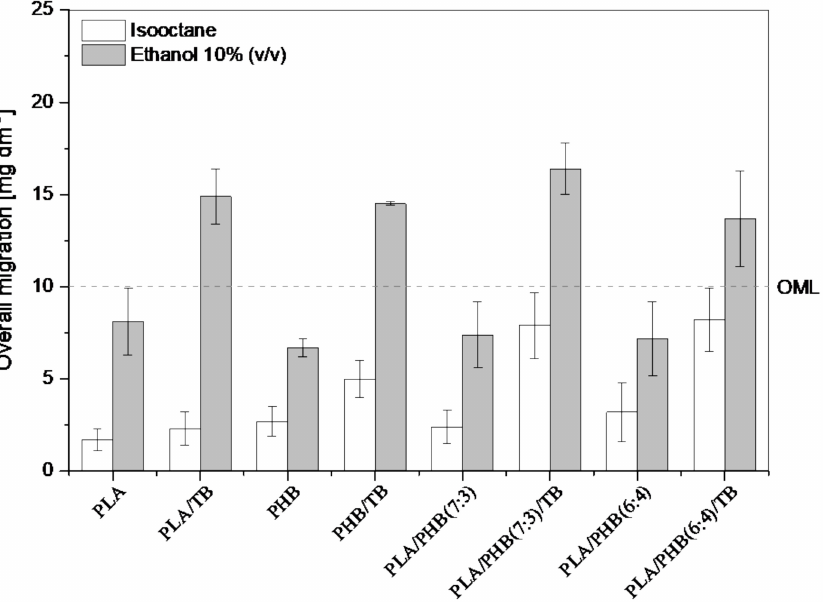
Figure 2. Overall migration data in isooctane and ethanol 10% ( v/v ) for PLA and PHB-based films. The dashed line indicates the overall migration limit